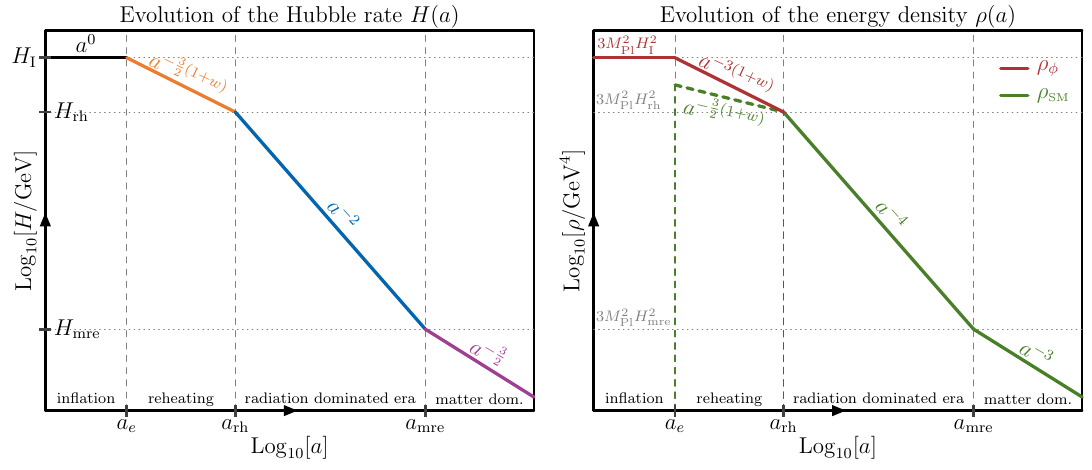
Figure 1 . The cosmological evolution of the Hubble rate H ( a ) (left-panel) and energy density (cid:26) ( a ) (right-panel) as a function of the scale factor a . The scale factor at the end of in(cid:13)ation a e , end of reheating a rh , and matter-radiation equality a mre are represented as gray dashed vertical